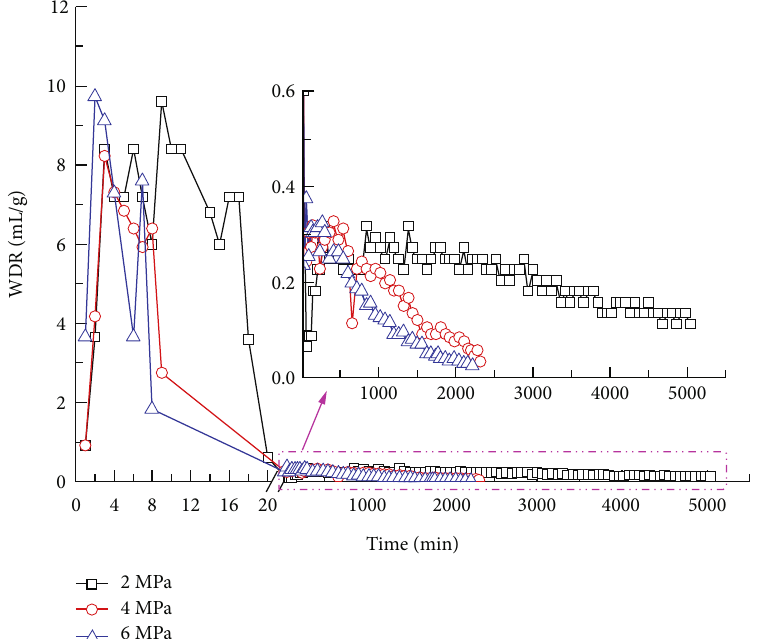
Figure 6: WDR under di ff erent water injection